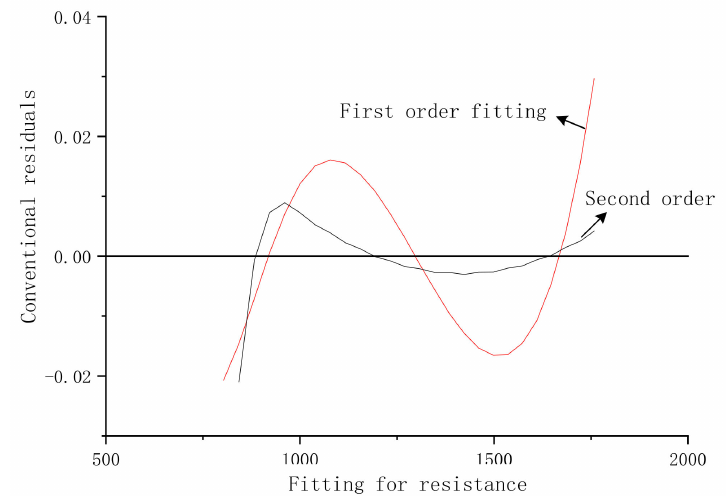
Figure 5. Comparison chart of the e ff ect of first-order and second-order fitting using the least square